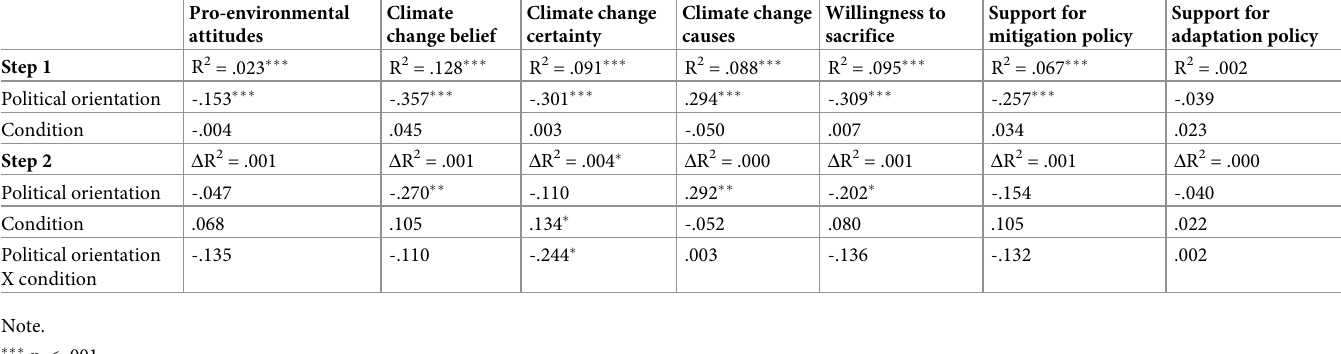
Table 5. Standardized regression coefficients regressing each DV on political orientation, condition, and the interaction term all participants, independent of rating